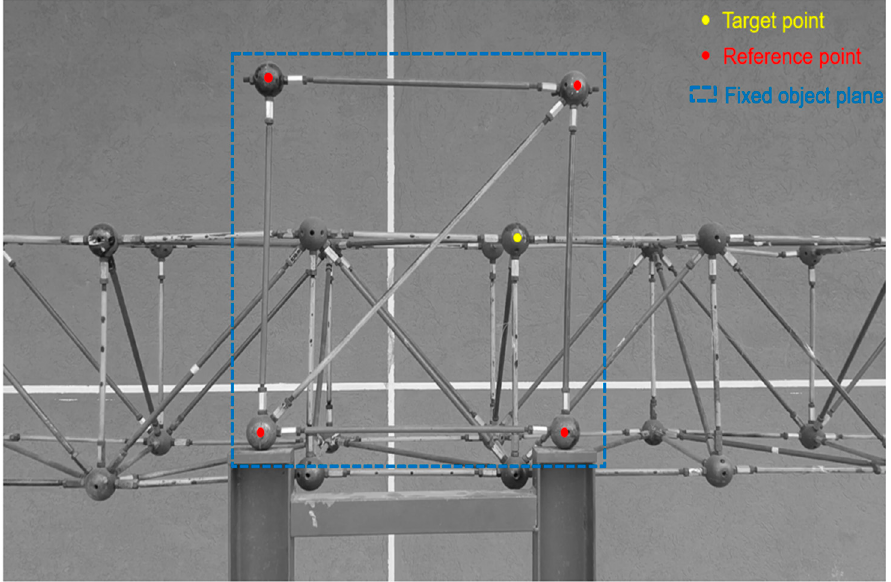
Figure 7. Measurement points.